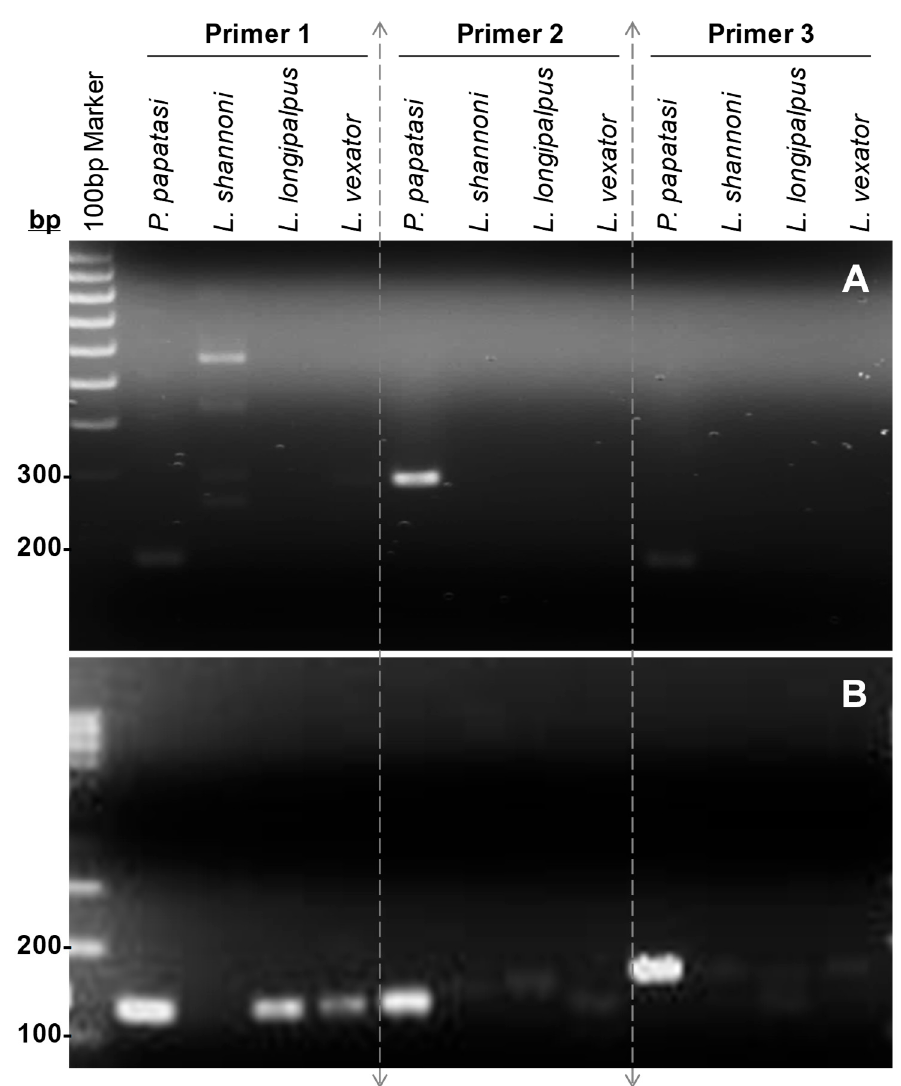
Figure 1. Selection of the diagnostic primer set for Phlebotomus papatasi . To search for P. papatasi -specific markers, two nucleus genes, salivary apyrase (accession number: AF261768); ( A ) and mammalian-like lipase (accession number: AY179968); ( B ) were used in this study. Three primer sets were designed for each mRNA within the regions with the lowest homogeneity. Primer sequences and projected amplicon sizes were listed in Table 1. Some bands of very low intensity were visible after running the gel but are not visible in photos. Notably, bands pertaining to all three non-target species appear when LIP primer set 3 is used.